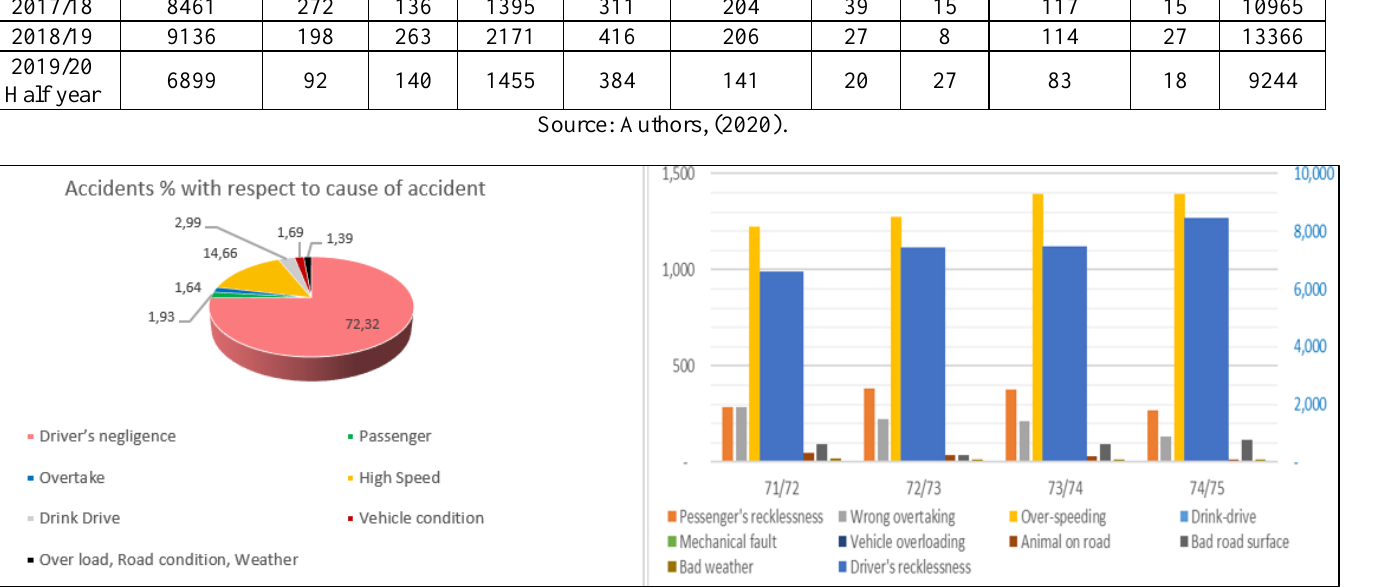
Figure18: Causes and Accident (Thickness of bar considered) from FY (2014/15). Source: